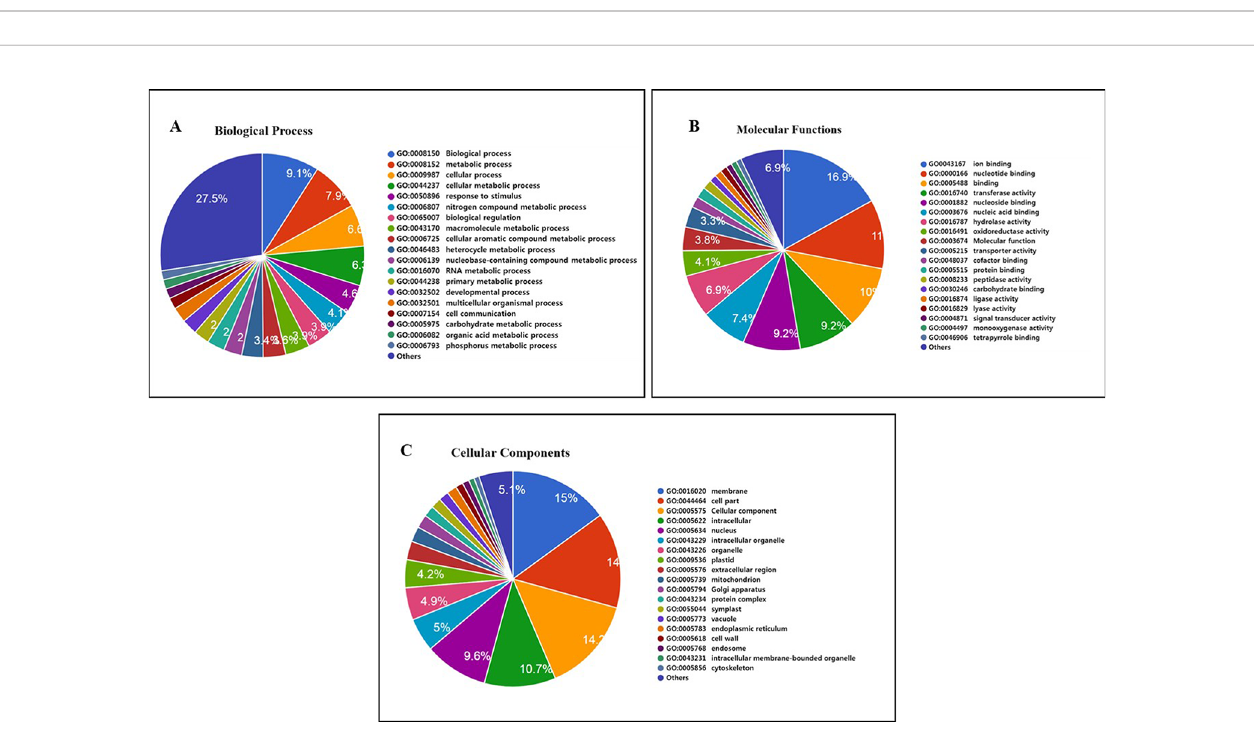
FIGURE 5 | Functional annotation of 1,132 mutated gene cluster of Basmati genome shared by Nipponbare, Kasalath, and Zhenshan 97 reference genomes. (A) Biological process. (B) Molecular function. (C) Cellular component.